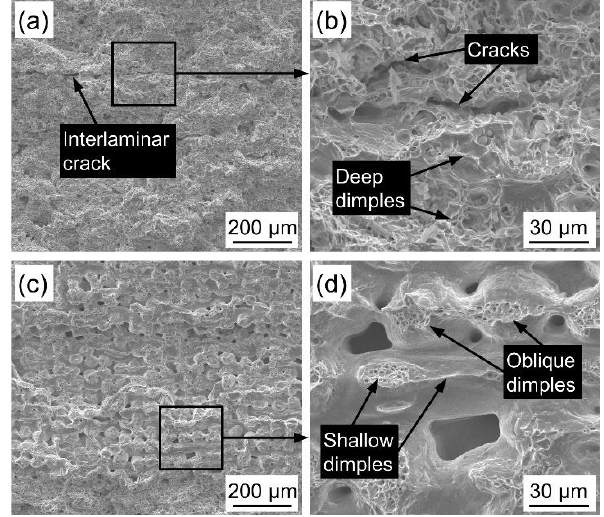
Figure 7. Impact fractures morphology of PWMCPPs with different wire mesh volume